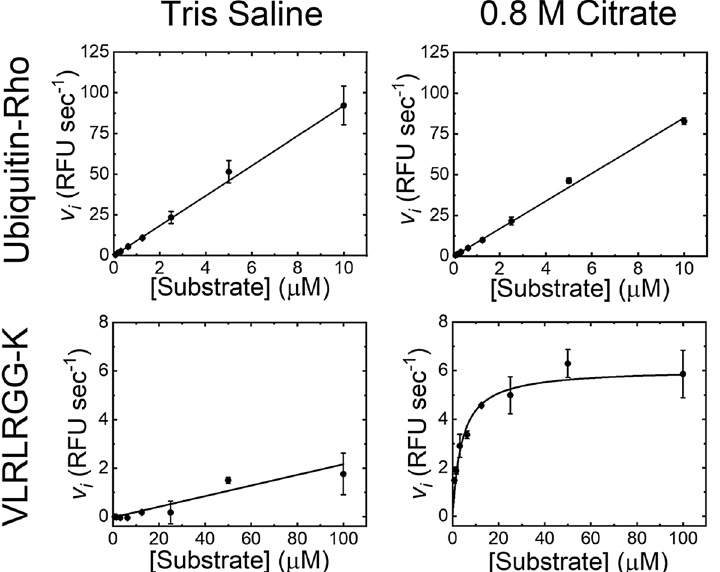
Figure 2. PL pro enzymology. The upper two panels show the initial rate of reaction for ubiquitin-rhodamine cleavage by PL pro in either tris-saline buffer or 0.8 M citrate. The lower two panels show the initial rate of substrate cleavage of a 7-mer peptide corresponding to the C-terminal of ubiquitin in either tris-saline buffer or 0.8 M citrate. The data points show the average of 4-replicates with error bars showing the standard deviation, with either a straight line or Michaelis–Menten fit shown as a solid black